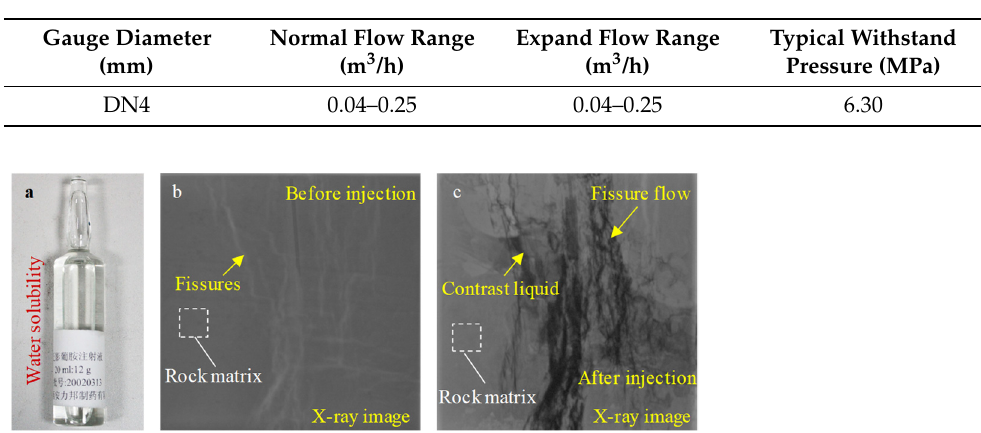
Figure 4. Comparison of meglumine diatrizoate developer and fissure flow before and after X-ray imaging. ( a ) Water solubility. ( b ) X-ray image feature of rock specimen before contrast liquid injection. ( c ) Fissure flow visualization in X-ray image of rock specimen after contrast liquid contrast injection.